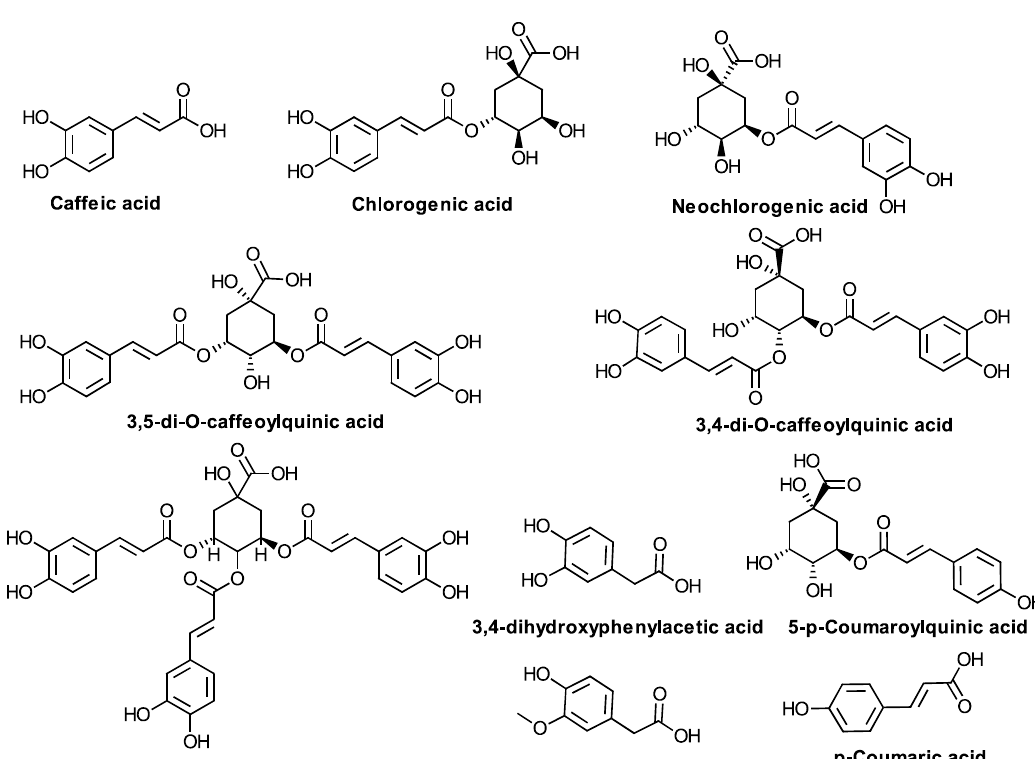
Figure 5. C6–C2 and C6–C3 compounds from S. virgaurea L.